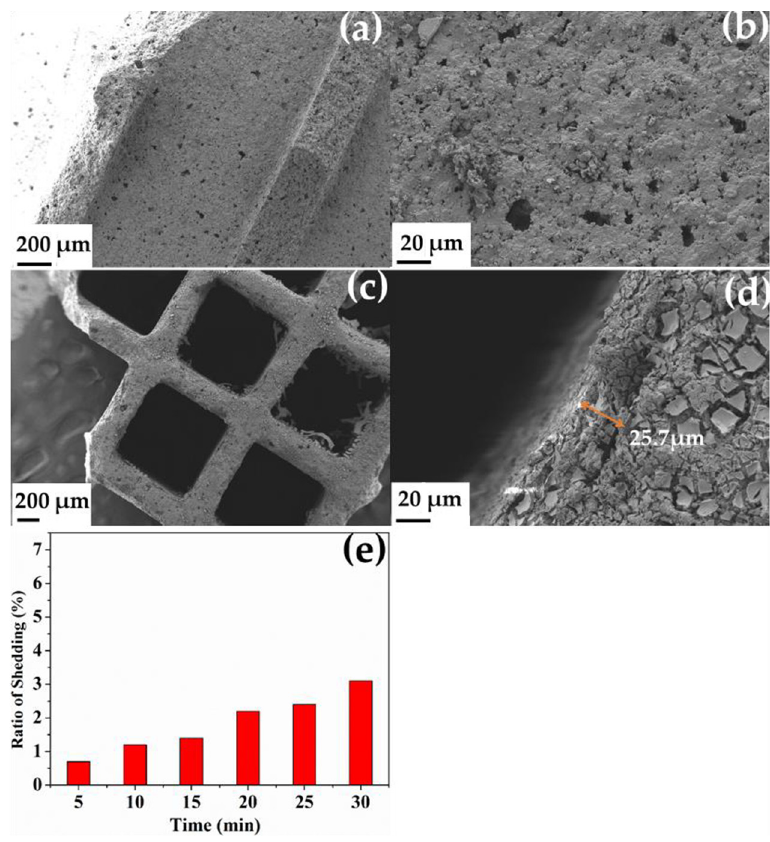
Figure 4. SEM images of blank honeycomb ceramics monolith ( a , b ), Mn 0.7 K 0.3 Co 2 O 4 -HC ( c , d ) and ultrasonic vibration test ( e ).